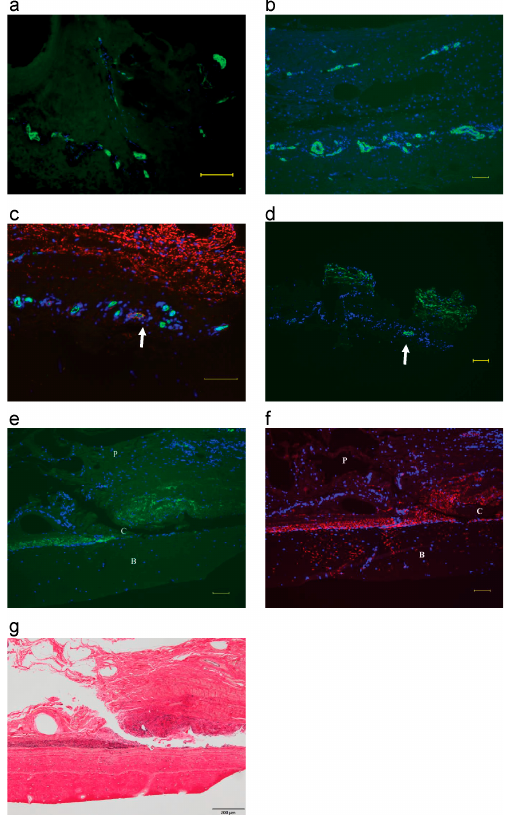
Figure 1. Localization of FBXW2 expression matched that of elastic fibers. ( a – d ) Fluorescent im- munostaining of the periosteum on day 0. Scale bar: 100 μ m: ( a ) Von Willebrand factor: green, 4 ′ ,6- diamidino2-phenylindole (DAPI): blue; ( b ) Alpha-smooth muscle actin ( α SMA): green, DAPI: blue; ( c ) FBXW2: red, Von Willebrand factor: green, DAPI: blue, arrow: microvessel with FBXW2; ( d ) Elastin: green, DAPI: blue, arrow: microvessel. ( e , f ) Histology of the periosteum and bone on